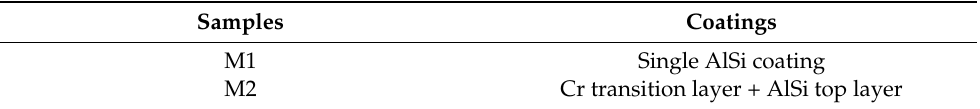
Table 1. Preparation details of all